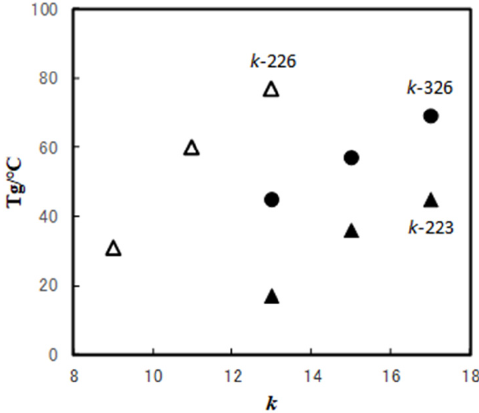
Figure 7. The k -dependence of the T gel of k -2-2-3 (solid triangles), k -2-2-6 (open triangles) [31], and k -3-2-6 (solid circles).